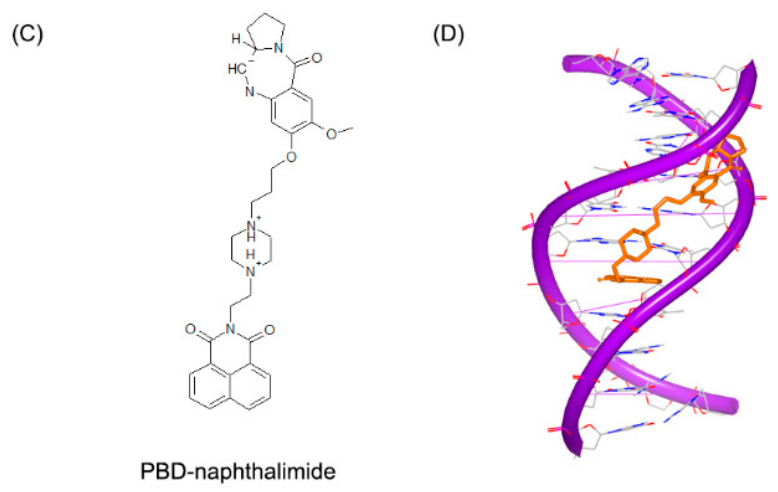
Figure 15. ( A ) Chemical structure of PBD-BIMZ; ( B ) complex of a DNA duplex with PBD-BIMZ (PDB code: 2KTT); ( C ) chemical structure of PBD-naphthalimide; and ( D ) complex of a DNA duplex with PBD-naphthalimide (PDB code: 2KY7). The orange structure represents the small molecule; the purple structure represents the backbone of nucleic acid; the blue and red atoms in the molecule represent nitrogen and oxygen atoms, respectively.